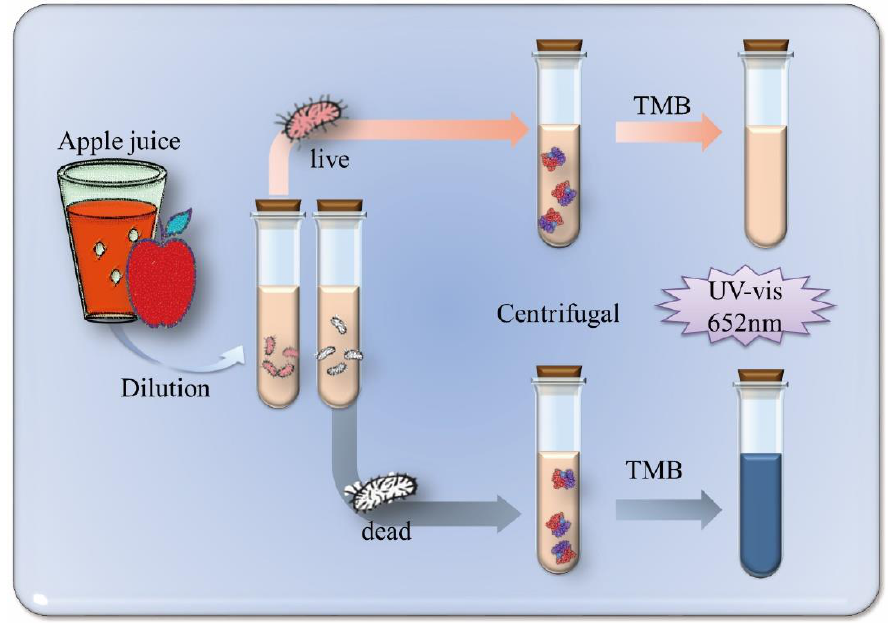
Figure S4: GOx@GA-Fe (ii) stability detection time span of 1 to 60 days; Figure S5: The steady-state kinetics of GOx@GA-Fe (II)/glucose (a) and GOx@GA-Fe (II)/TMB (b). Table S1: Comparison of the ability of different nanometer synthases to detect